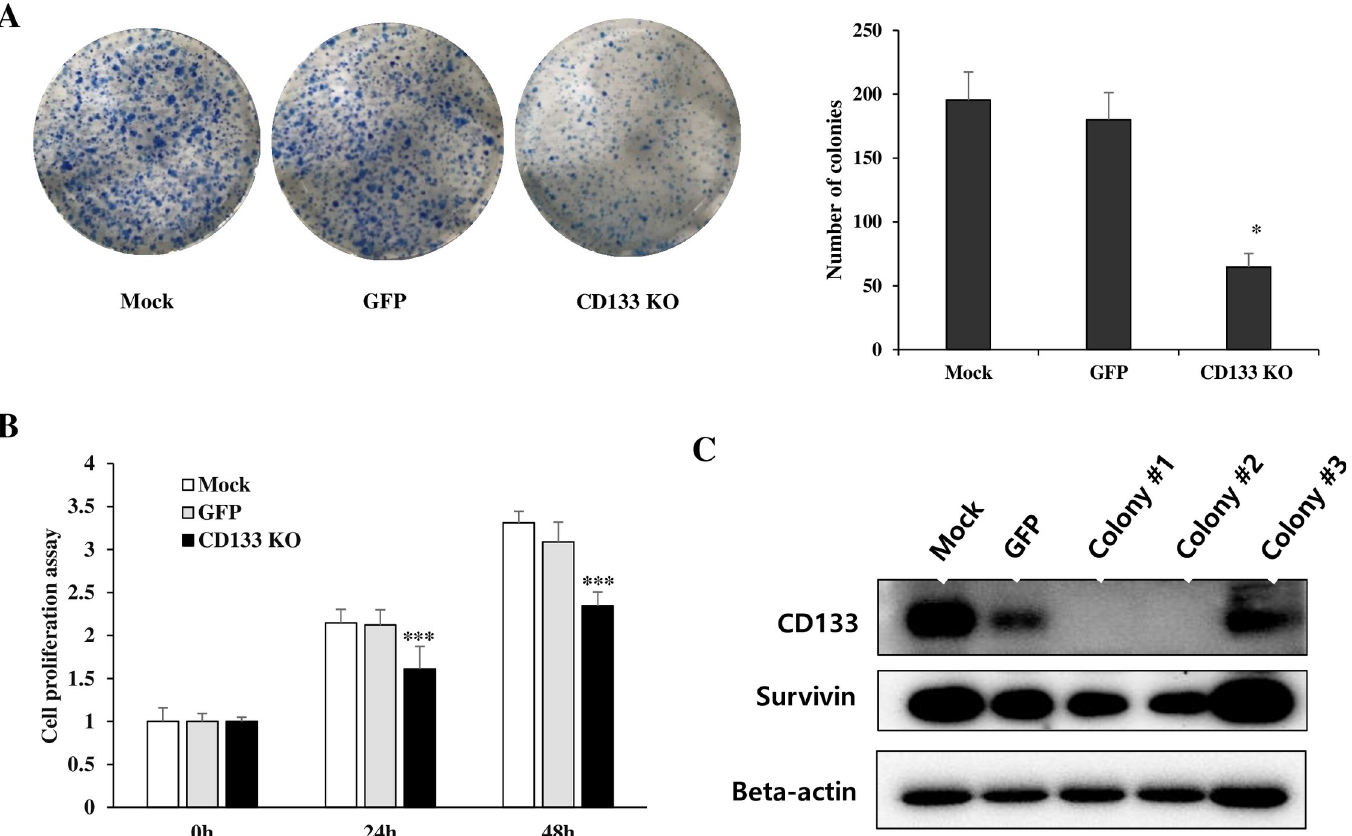
Fig 2. CD133 knockout inhibited cell colony formation and proliferation. ( A ) Representative photographs of the colony formation assay demonstrated that the smallest number of colonies was observed in the CD133 knockout group compared with mock and GFP groups (mock vs . CD133 KO, P = 0.017; GFP vs . CD133 KO, P = 0.0172; � P < 0.05). ( B ) WST-1 assay also showed a significant reduction in cell proliferation of CD133 knockout cells compared with mock and GFP groups ( ��� P < 0.001). ( C ) In western blot, we confirmed that the CRISPR-Cas9 mediated CD133 knockout cells in colony #1 and #2 showed decreased survivin expression, compared to the mock, GFP and CD133 + cells in colony #3. (GFP, CRISPR-Cas9 mediated control group; CD133 KO, CRISPR-Cas9 mediated CD133 knockout group).